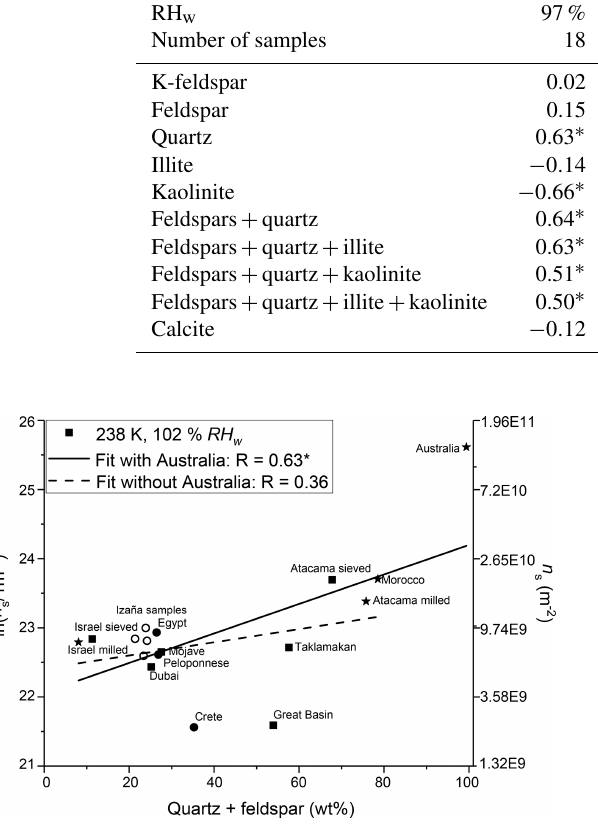
Figure 2. Natural log of the ice-active surface site density as a function of the sum of quartz and feldspar content of the samples. Square symbols indicate surface-collected samples, stars indicate milled samples, and circles indicate airborne samples. For clarity, the Tenerife samples are not named individually and are instead shown as open circles. The asterisk in the legend indicates that the correlation is significant at the 0.05